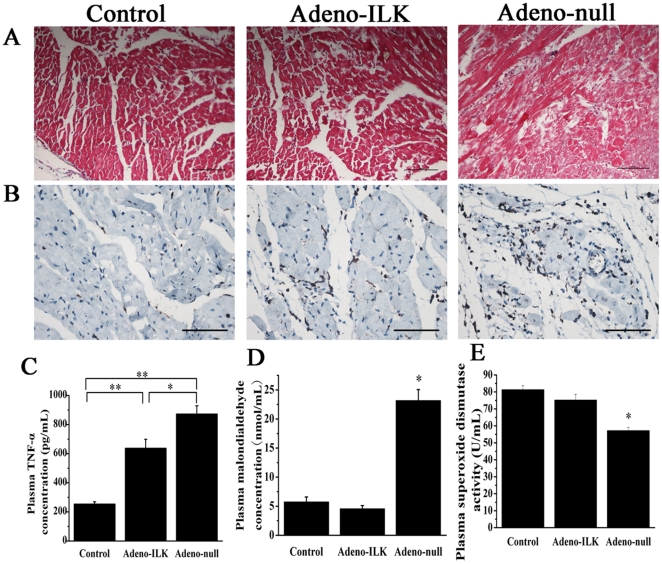
Cardiac ILK gene therapy prevents inflammation and cardiomyocyte degeneration, and improves markers of systemic inflammation and oxidative stress, in doxorubicin-induced heart failure.A–B, Hematoxylin-eosin (A) and CD45 staining (brown) (B) of myocardium 4 weeks following adeno-ILK or adeno-null treatment, showing effects on cardiomyocyte degeneration (myofibrillar derangement and disruption) and inflammatory cell infiltration. C–E, Plasma tumor necrosis factor-α (TNF-α) concentration (C), malondialdehyde concentration (D) and superoxide dismutase activity (E), in control (saline-treated) as well as doxorubicin-treated rats receiving either adeno-ILK or adeno-null. n = 6 per group. *, ** P<0.05 and <0.01 respectively. Scale bars: 100 µm.